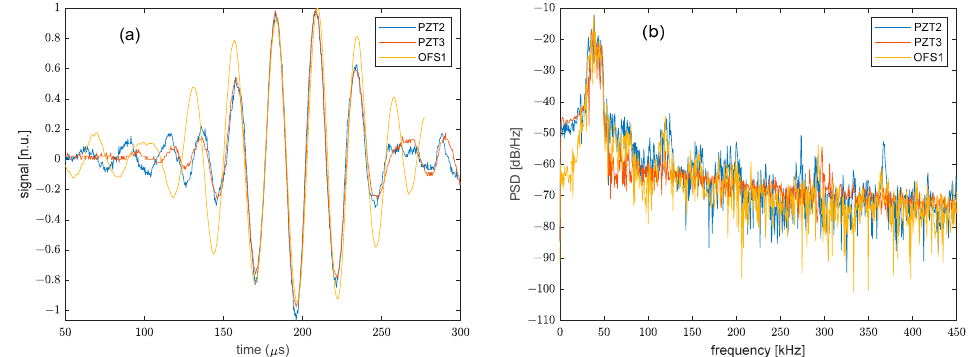
Figure 6. ( a ) Response of PZT2, PZT3, and OFS1, with the latter temporally translated for alignment with the PZT signals and ( b ) corresponding power spectral densities.